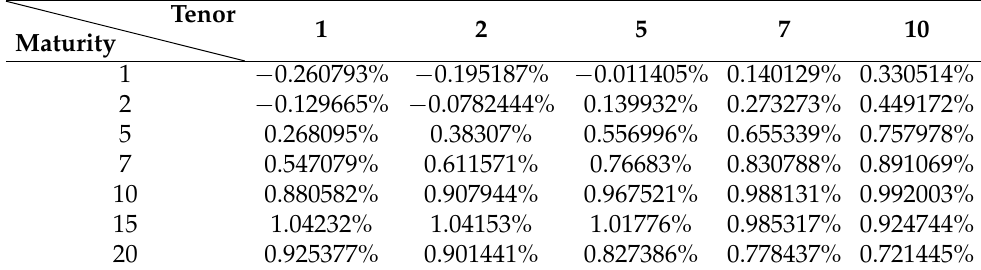
Table A2. Market data containing the swaption strikes on 30 December 2019.